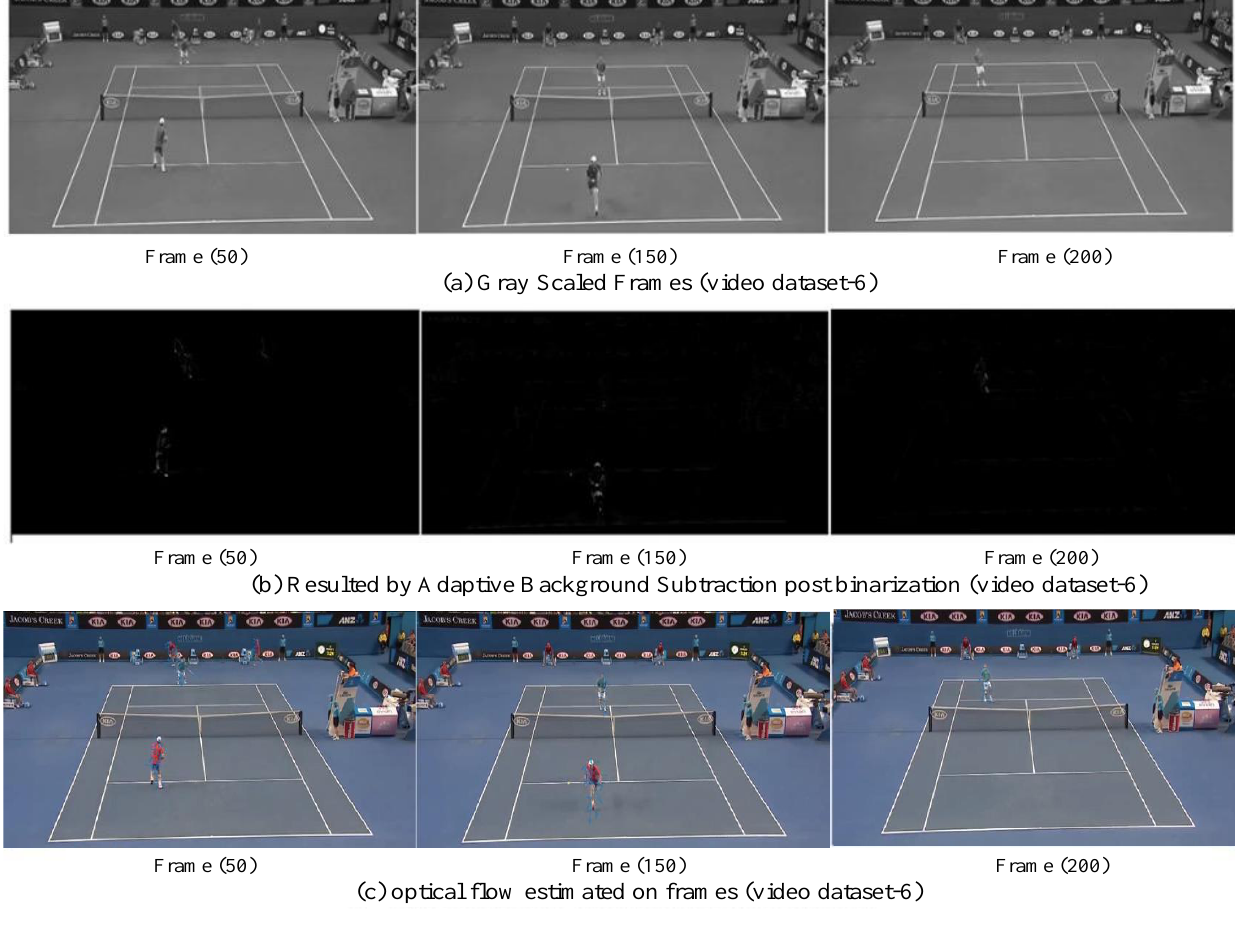
Figure 14. Simulation results from video dataset 6 by the proposed framework (( a ) extracted frames in grayscale, ( b ) foreground by adaptive background subtraction post-binarization and ( c ) optical flow).